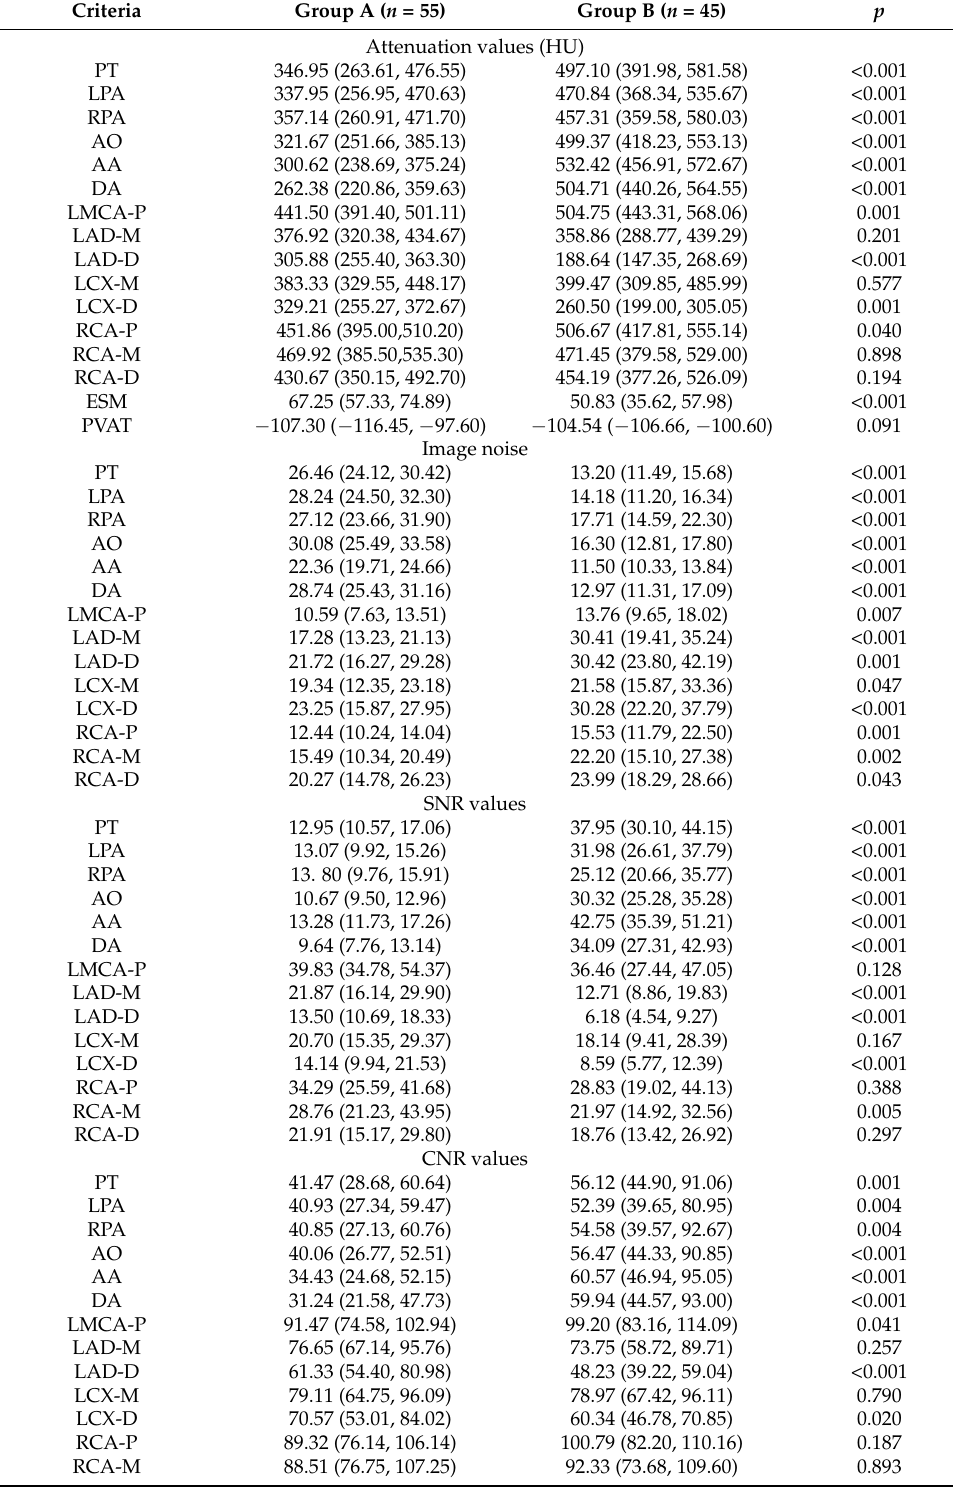
Table 4. Results of the objective quality